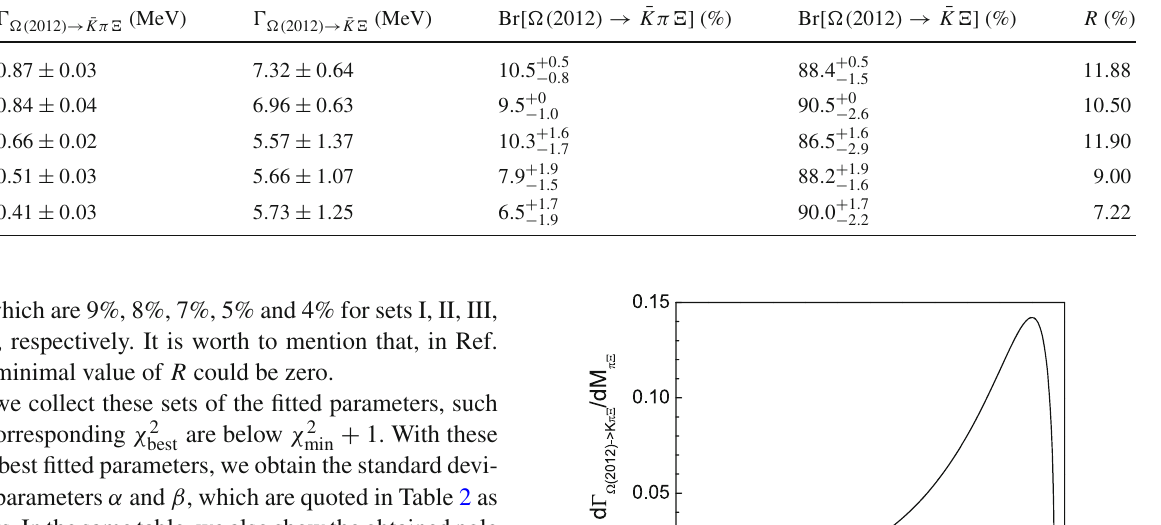
Table 3 The predicted results for the two and three body strong decays of the (cid:2)( 2012 ) with the fitted parameters given in Table 2 Set (cid:6) (cid:2)( (MeV) 2012 ) → ¯ K π(cid:3)